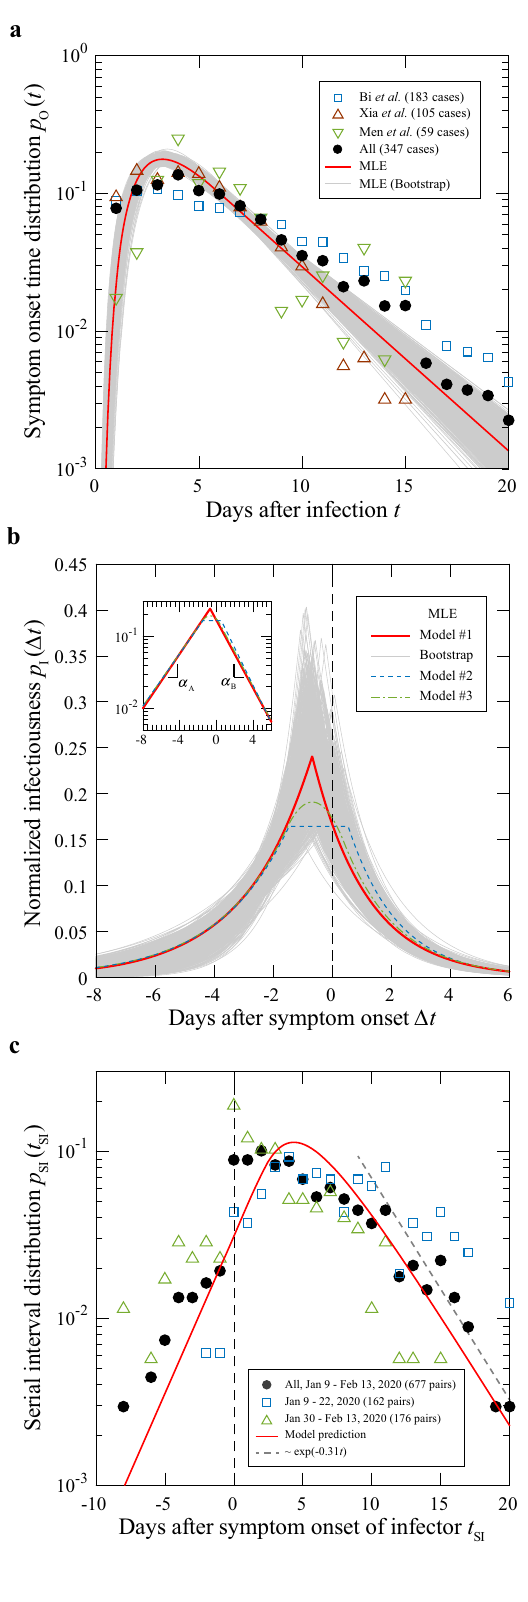
before and after the Wuhan lockdown. Such temporal effect on the serial interval can be simulated simply with a shape function that masks p I ( Δ t ). For example, imported index cases who spent part of their infectious period outside the region shift p SI ( t SI ) to the right. On the other hand, vigorous contact tracing shortens isolation delays signi fi cantly, which in turn shifts p SI ( t SI ) to the left. the two wings are joined together in the peak region. In the fi rst case, the two exponential tails join directly to produce a cusp in the rates α A and α B associated with the infectiousness curve. We have computed the tail of the probability q L ( t ) to remain in the the middle. In the second case, a fl at top of variable width is introduced. In the third case, the fl at top is replaced by a latent phase, whose decay rate matches that of p O ( t ) (see Supplementary Section 2.4). According to Eq. (1), the long-time parabolic cap to give a more rounded peak. It turns out that the NATURE COMMUNICATIONS| (2021) 12:1147